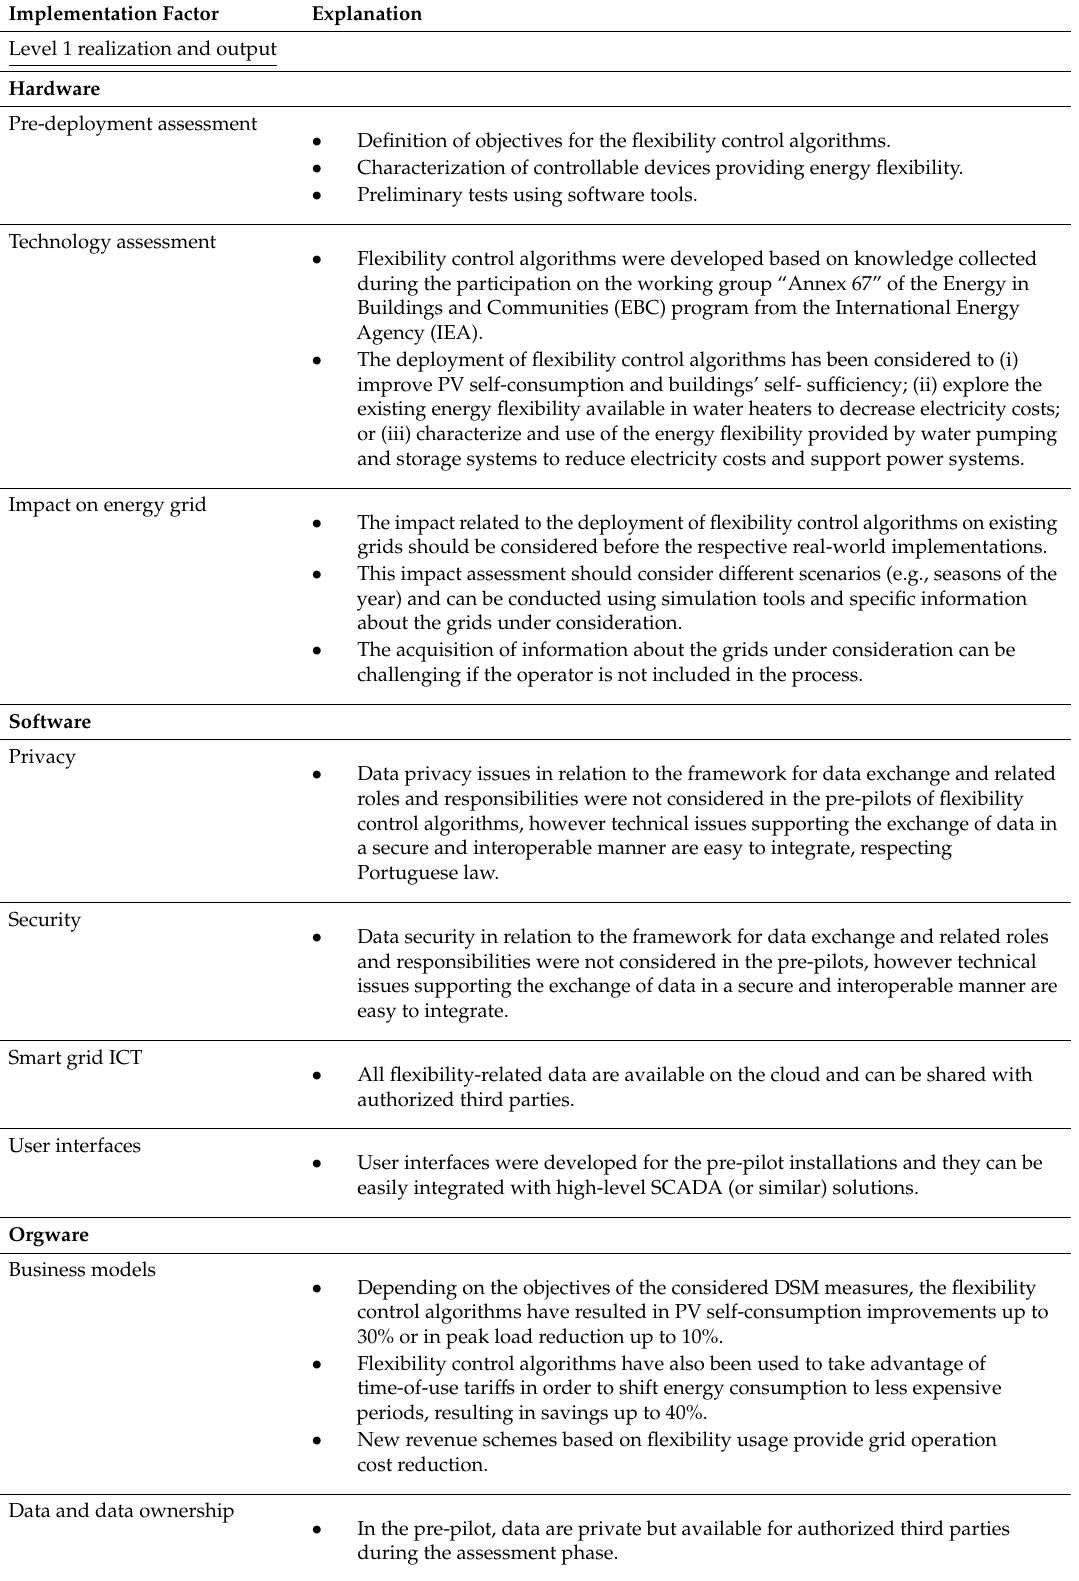
Table 3. Mapping É